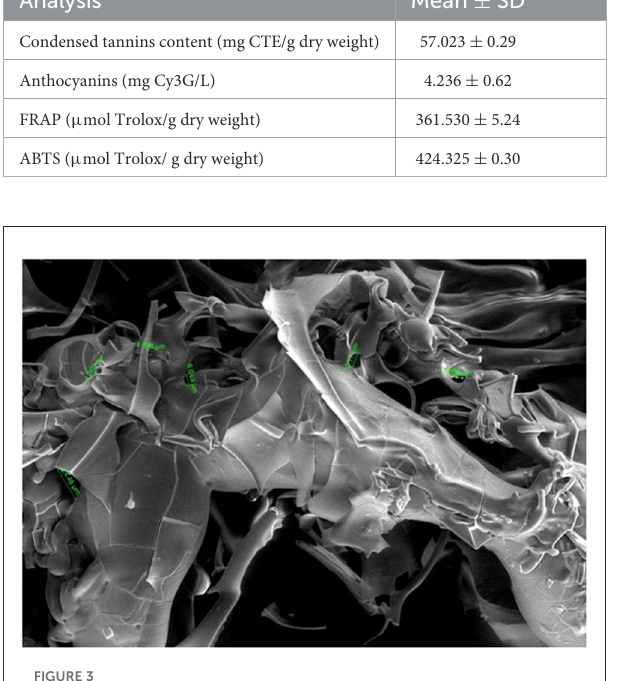
TABLE 5 Anthocyanins, condensed tannin, and antioxidant screening of the extract ( n = 3). Analysis